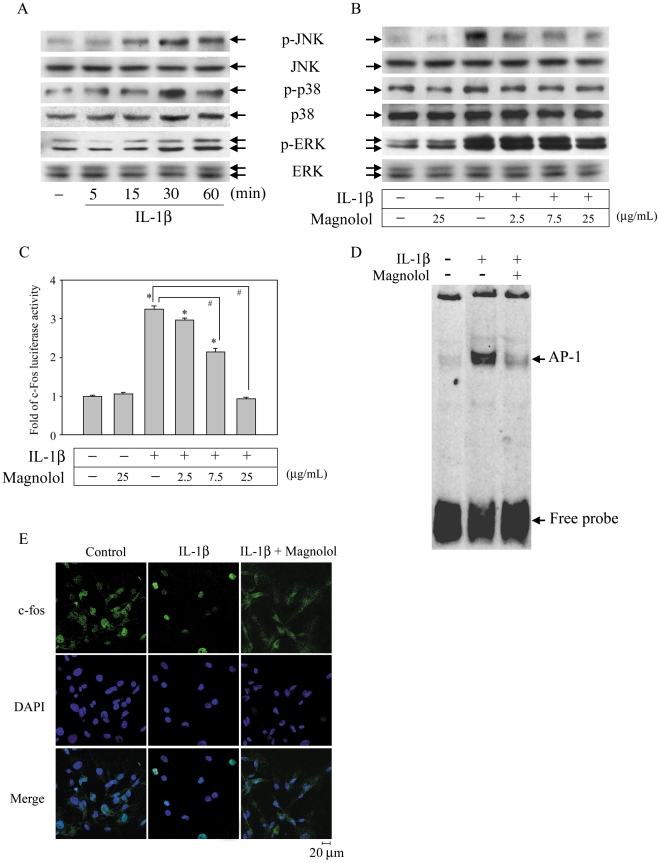
Magnolol inhibits MAPK pathways and c-fos nuclear translocation.Cells were treated with 10 ng/mL of IL-1β for different time periods (A) or were treated with magnolol at the indicated concentration for 30 min, then stimulated with IL-1β in the continued presence of magnolol for 30 min (B). The cells were then harvested and whole cell extracts prepared for Western blot analysis for the indicated proteins. (C) Cells (1×105 cells) were transiently transfected with 1 µg of p5xATF6-GL3 for 24 h, then incubated with 0–25 µg/mL magnolol for 30 min before activation with 10 ng/mL of IL-1β in the continued presence of magnolol for another 6 h, when luciferase activity was measured as described in the “Materials and Methods”. The results are expressed as the mean ± standard error of the mean (SEM), with n = 3. * p<0.05 compared to the control group; #p<0.05 for the comparison of the indicated groups. (D) Cells were incubated with vehicle or IL-1β (10 ng/mL) for 1 h or were pretreated with 25 µg/mL of magnolol for 30 min, then stimulated with IL-1β in the continued presence of magnolol for 1 h. Nuclear extracts were then subjected to a DNA-binding reaction with oligonucleotides specific for AP-1. The specific DNA-binding activity of the AP-1 complex is indicated by an arrow. (E) Cells (1×105 cells) were incubated with or without 25 µg/mL of magnolol for 30 min, then stimulated with 10 ng/mL of IL-1β in the continued presence of magnolol for 1 h, when samples were prepared for confocal microscopy analysis. Scale bar = 20 µm.